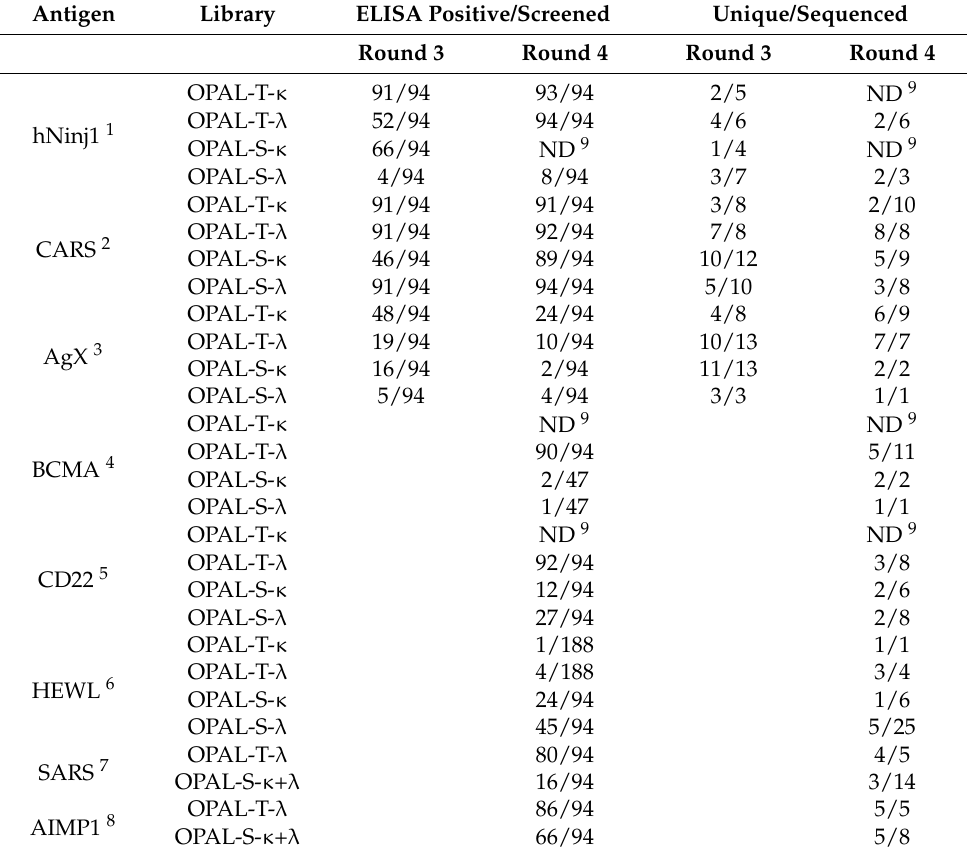
Table 2. Comparison of the panning performances between OPAL-S and OPAL-T using a panel of antigens. Antigen Library ELISA Positive/Screened Unique/Sequenced Round 3 Round 4 Round 3 Round 4